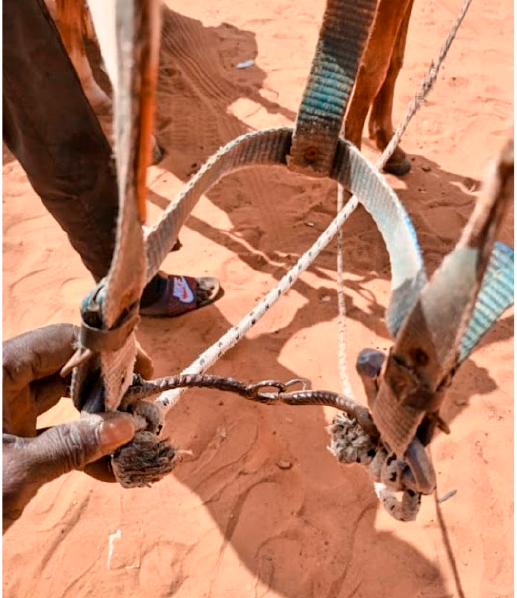
Figure 6. Locally produced bit in Senegal made from narrow pieces of construction iron with ridged surfaces.